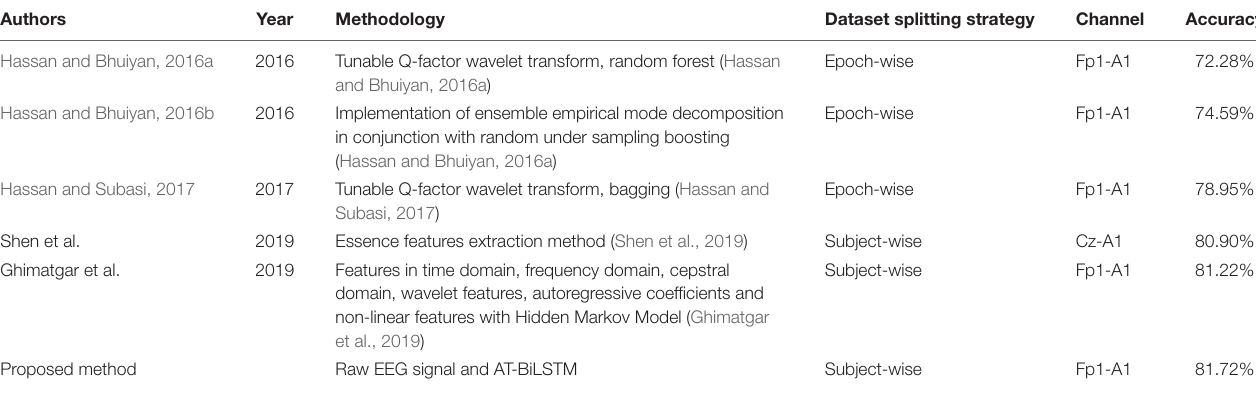
TABLE 7 | Comparison of sleep staging performance on the DRM-SUB dataset between the proposed method and previous works based on conventional feature